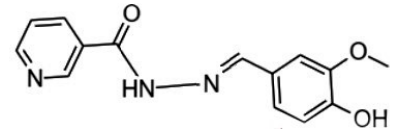
Figure 1. The molecular structure of nicotinehydrazide .